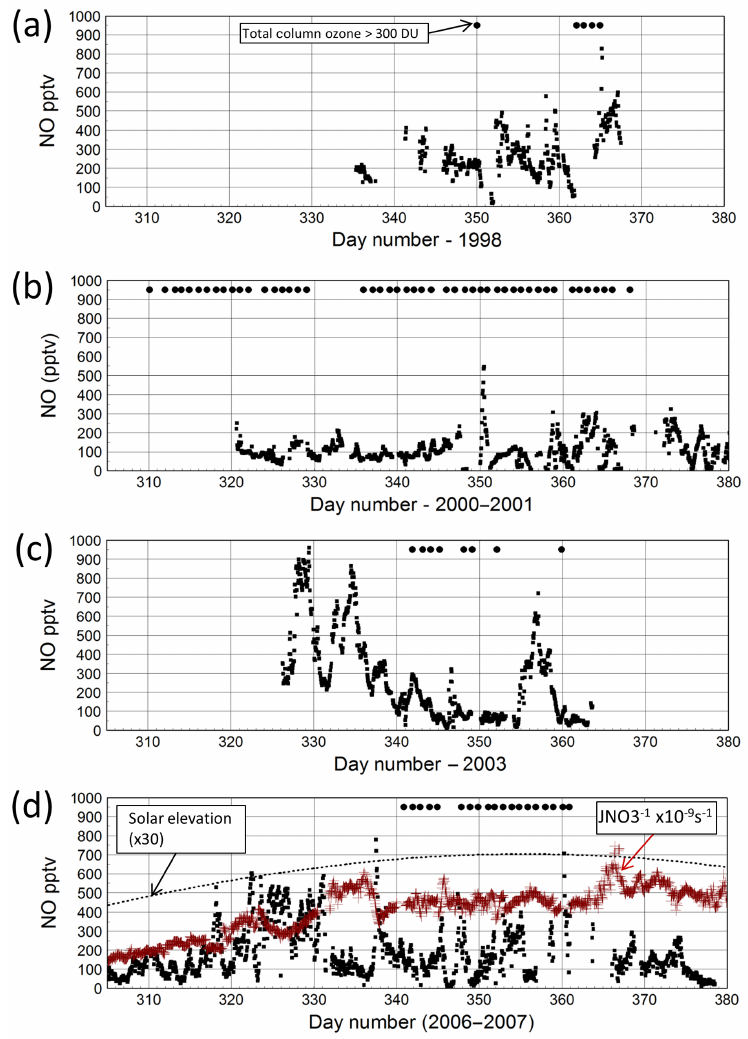
Figure 1. Periods of data collection used in our analysis for (a) 1998, (b) 2000–2001, (c) 2003, and (d) 2006–2007. Periods of daily total column ozone in excess of 300 DU appear at the top of each panel. In (d) the seasonal change in solar elevation angle (x30) is shown together with the nitrate photolysis rate ( J NO − 1 3